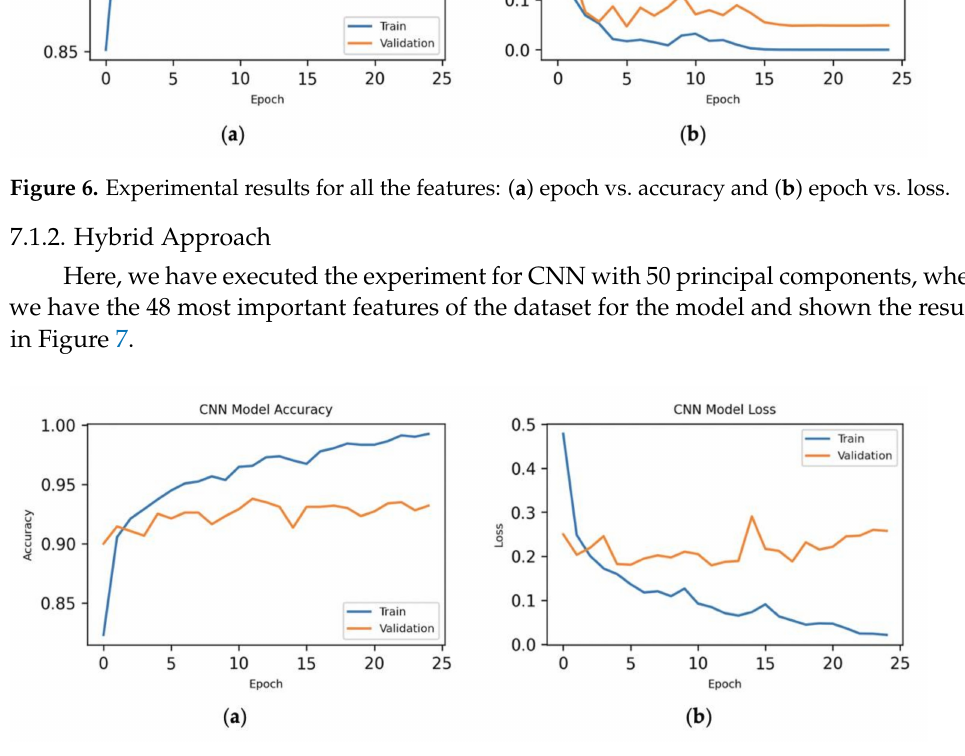
Figure 7. Experimental results for 48 features: ( a ) epoch vs. accuracy and ( b ) epoch vs. loss.